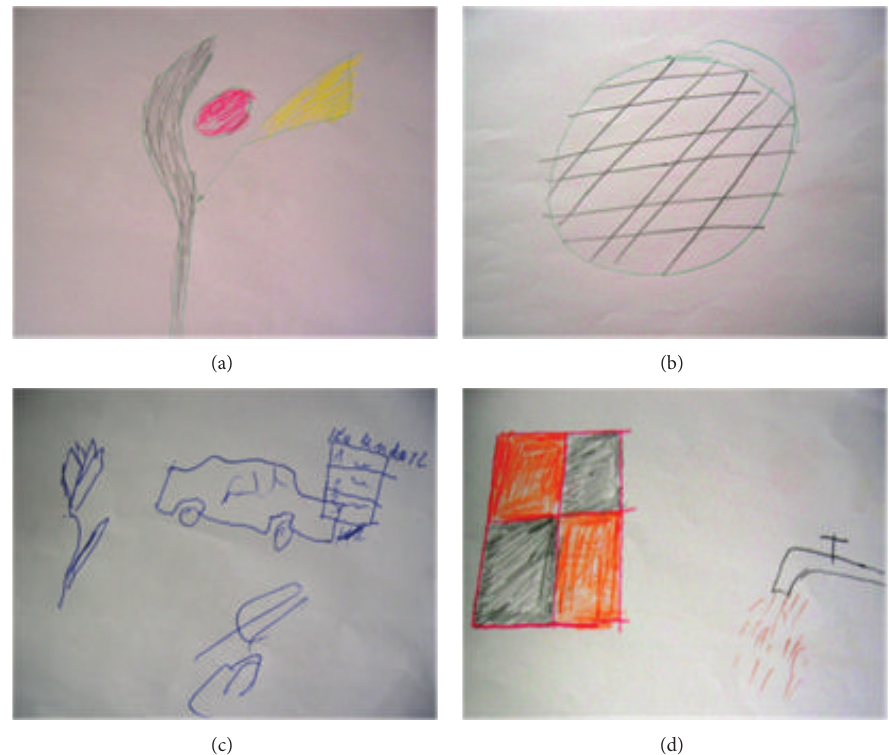
Figure 1: The drawings made by the patient (case 1) showing visual illusions ((a)-(b)) and visual pseudohallucinations ((c)-(d)).